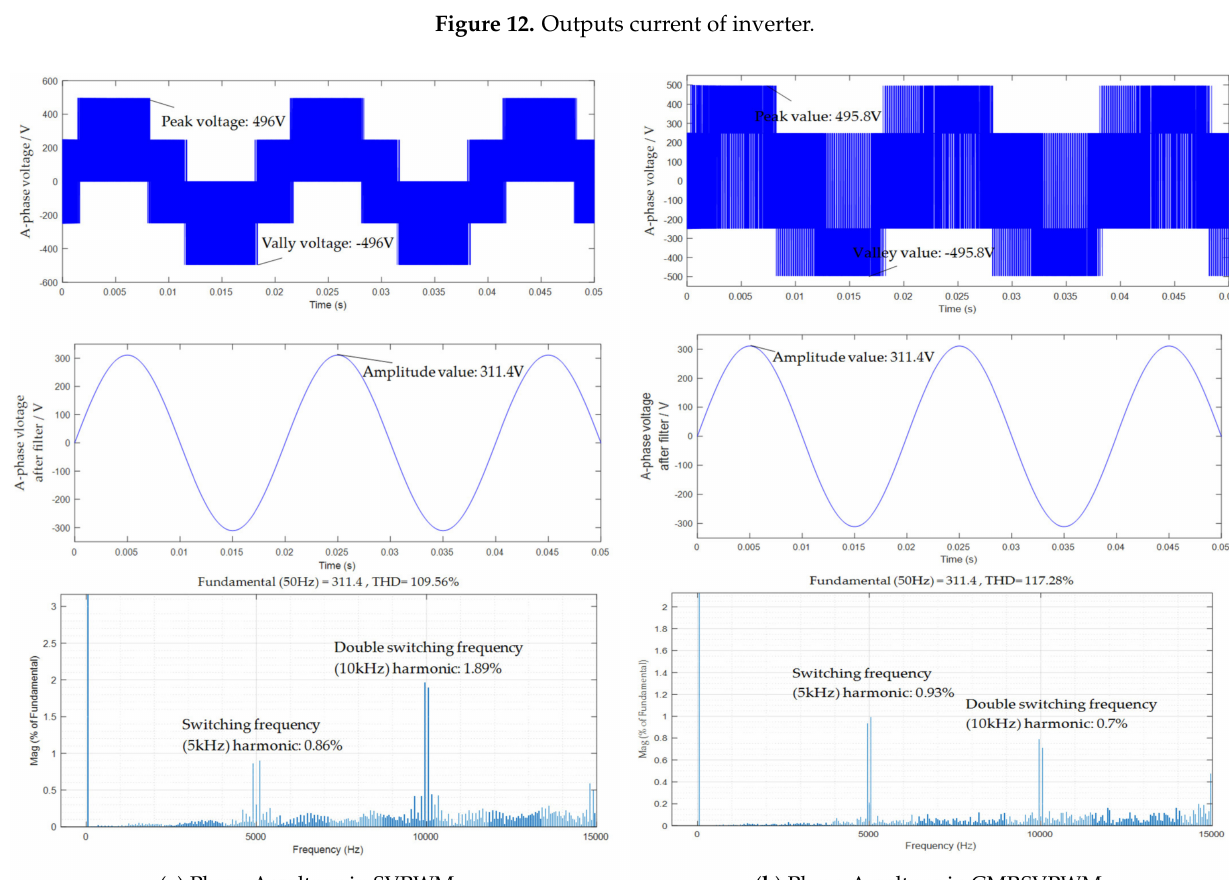
Figure 12. Outputs current of inverter.